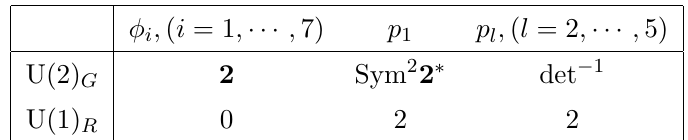
Table 1 . The charge assignment for lowest component scalars in the chiral multiplets of equivariant A-twisted GLSM for X 2 ; 7 Sym 2 S (cid:3) (cid:8)O (1) (cid:8)